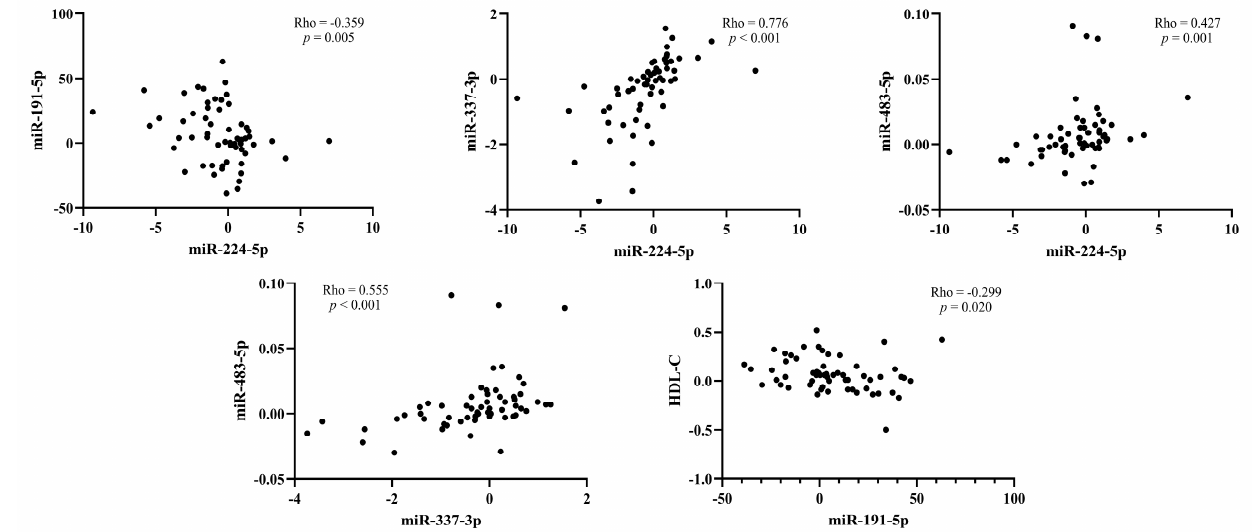
Figure 5. Significant correlations between changes in miRNAs expression and lipid parameters after PCSK9 inhibition. HDL-C, high-density lipoprotein cholesterol.